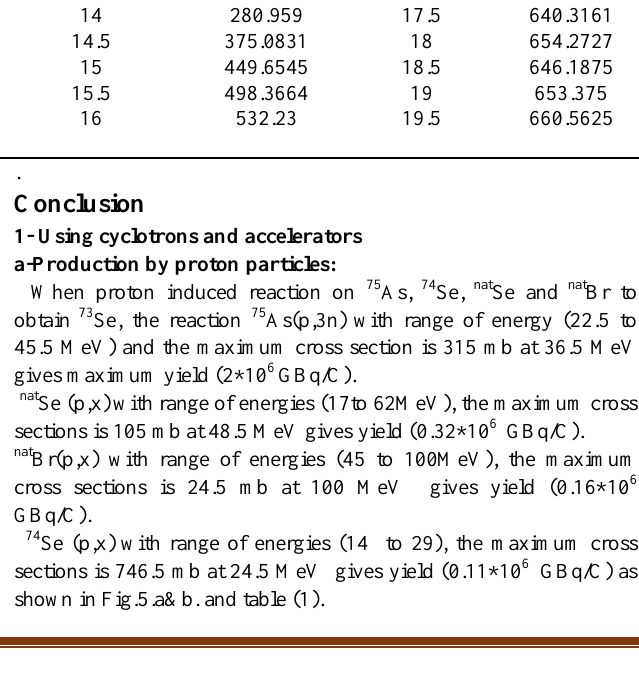
Figure.11 . Excitation Function for Production 73 Se for the Reactions 74 Se (n, 2n) 73 Se. Table 2 : Excitation Function for Production 73 Se for Figure 10: a. Excitation function for production 73 Se for the reactions nat Ge ( 3 He,x) , 70 Ge (α,n) and 72 Ge (α,3n).b. Isotopes production yield for the reactions natGe (3He,x) , 70Ge (α,n) and 72Ge (α,3n)